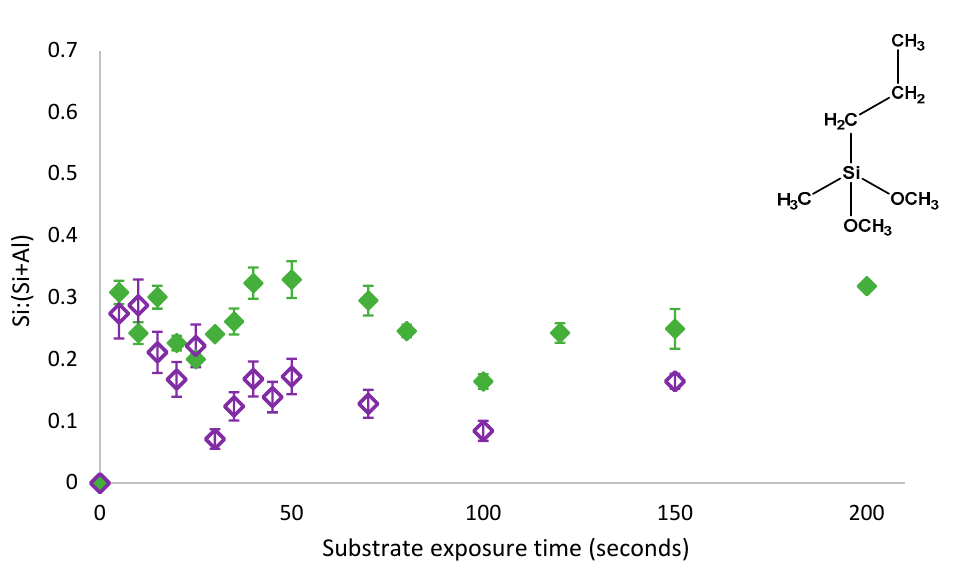
Figure 4. Oscillatory adsorption of 1% PMDMS in 1:1 EtOH:H 2 O solvent at pH3 on aluminium foil measured using XPS. Upon removal from solution, films were either dried with N 2 (solid purple diamonds) [8] or rinsed with pH3 CH 3 COOH (open purple diamonds) prior to drying and curing.